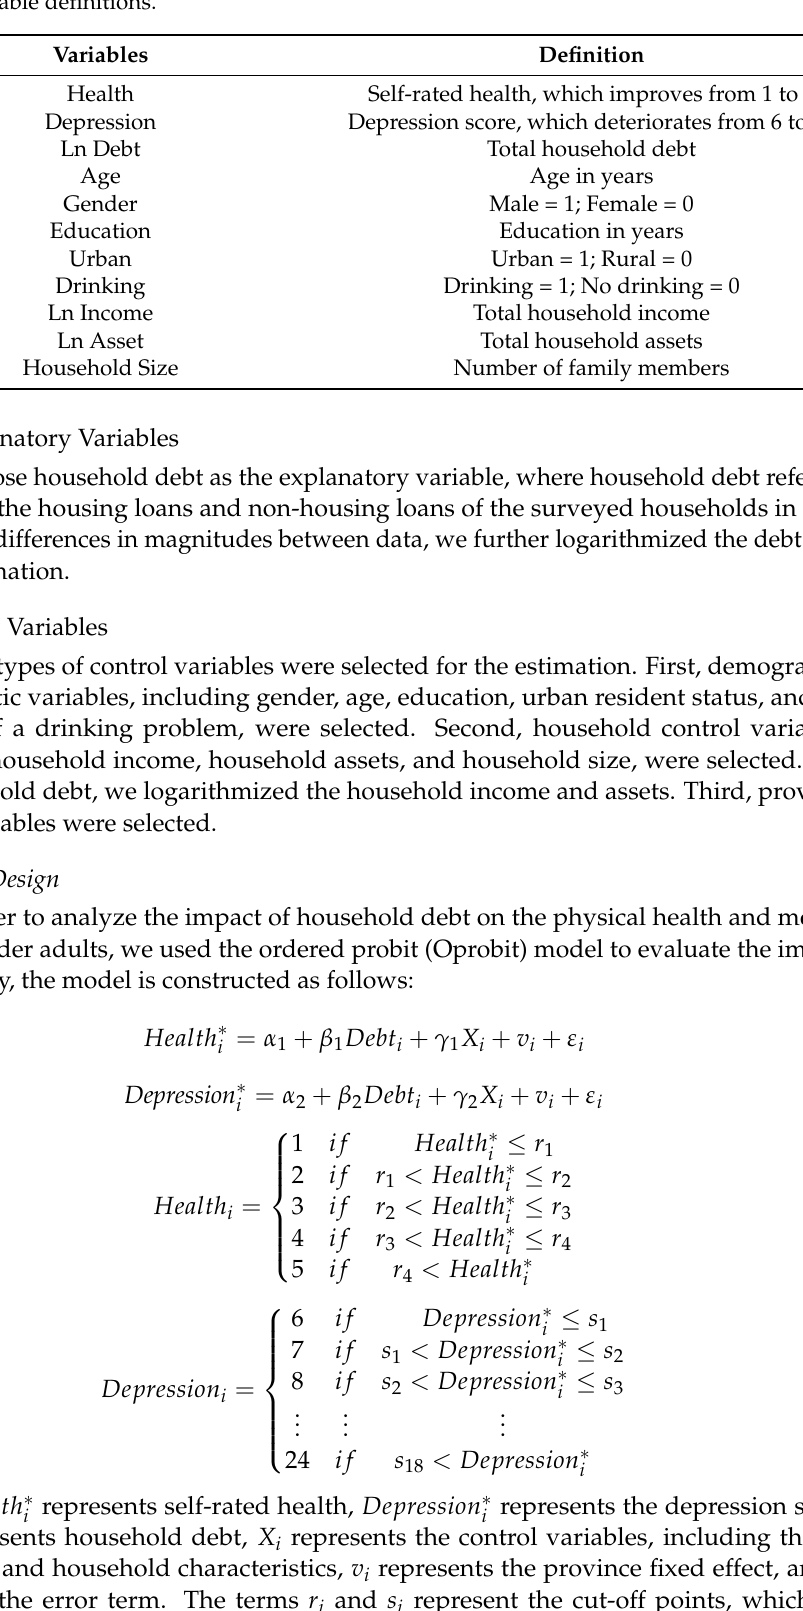
Table 1. Variable